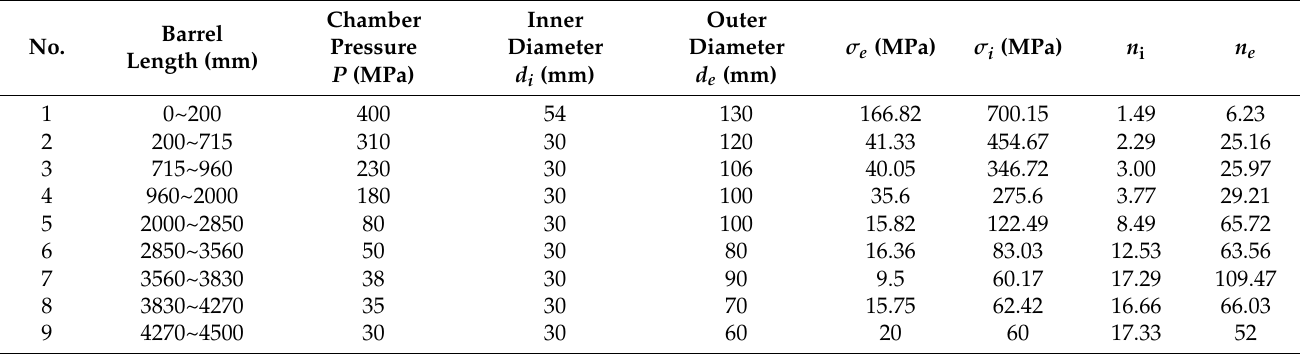
Table 1. Strength verification of the tube